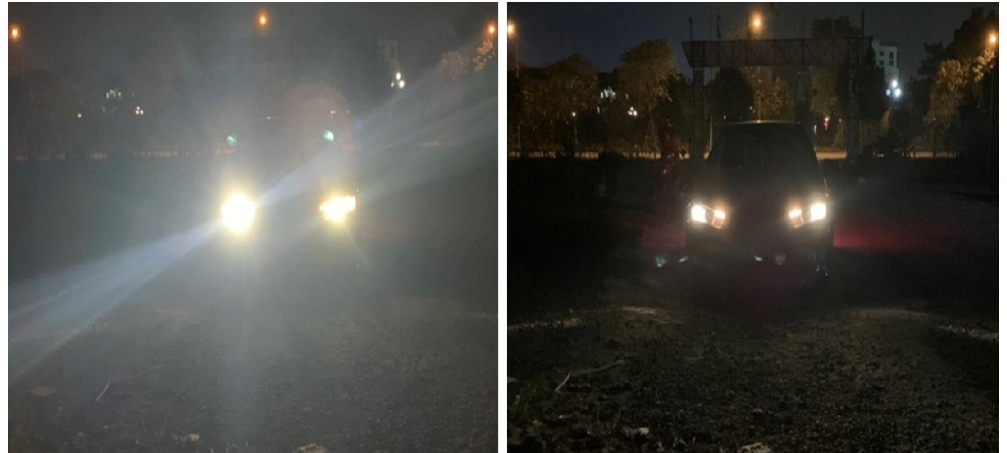
Figure 3. Pictures of polarizing filter-equipped LED headlights, observed with ( right ) and without ( left ) the polarizing fl ip plate.